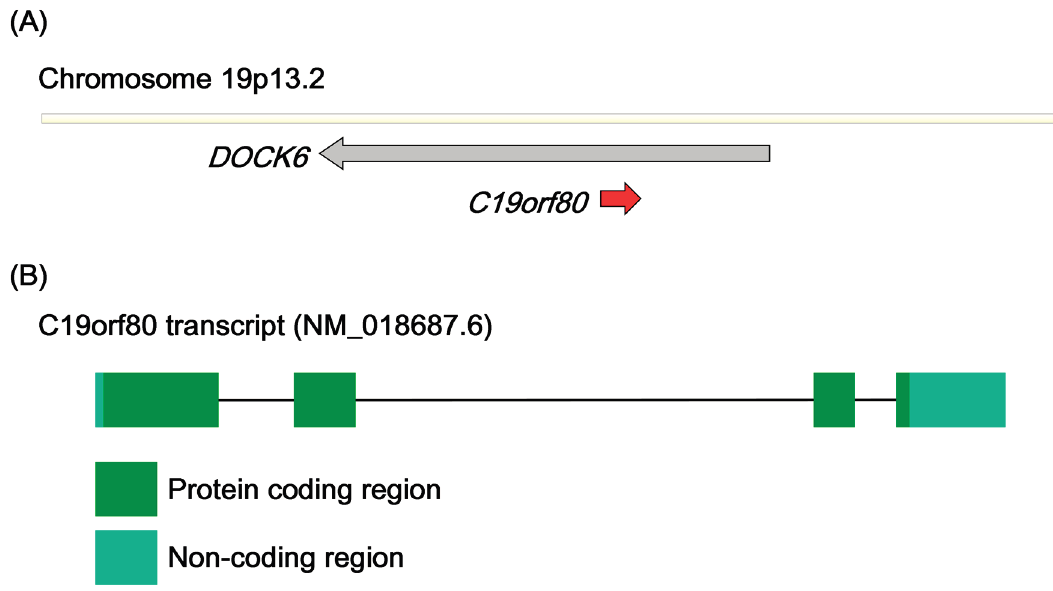
Figure 1. Gene structure of Homo sapiens C19orf80 (betatrophin). ( A ) The betatrophin gene is located on chromosome 19p13.2; ( B ) The human betatrophin transcript